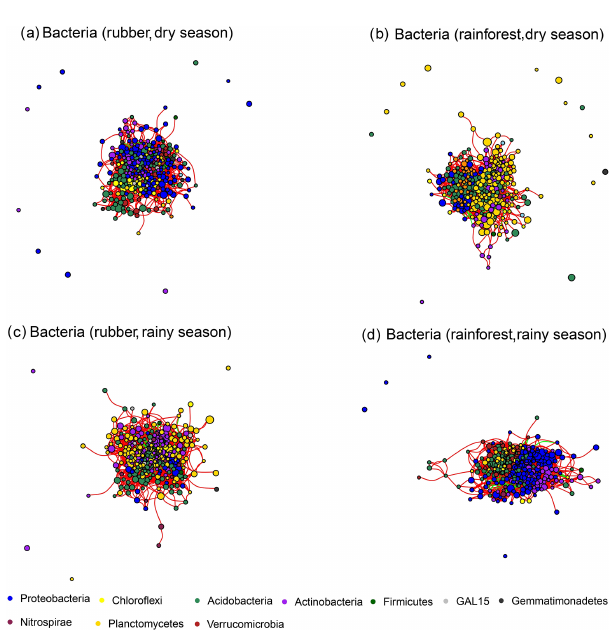
Figure 2. The soil bacterial network structure of rubber plantations and tropical rainforests in the dry and rainy seasons. Red lines indi- cate a positive correlation between OTUs, and green lines indicate a negative correlation. The absolute value of the correlation coeffi- cient ρ > 0 . 6 ( P < 0 .